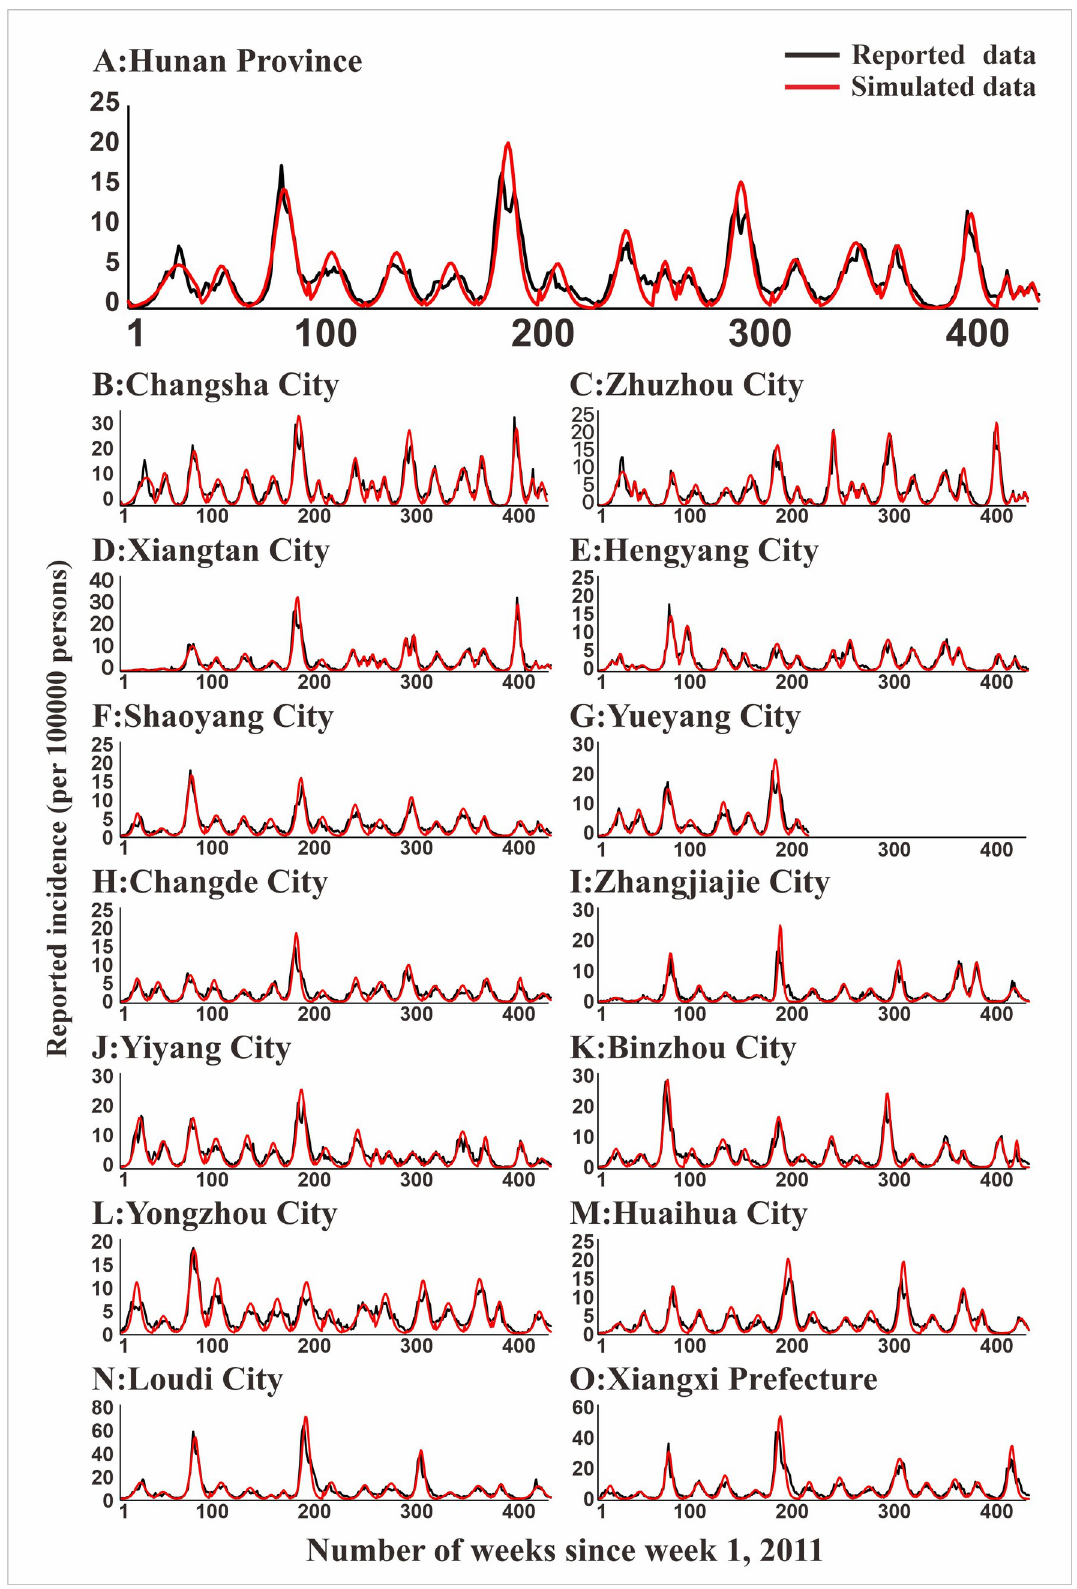
Fig 5. Epidemics of HFMD and LDE model fittings within Hunan Province and its 14 regions. (A: Hunan Province; B: Changsha City; C: Zhuzhou City; D: Xiangtan City; E: Hengyang City; F: Shaoyang City; G: Yueyang City; H: Changde City; I: Zhangjiajie City; J: Yiyang City; K: Chenzhou City; L: Yongzhou City; M: Huaihua City; N: Loudi City; O: Xiangxi Prefecture). https://doi.org/10.1371/journal.pntd.0009233.g005 PLOS NeglectedTropical Diseases | https://doi.org/10.1371/journal.pntd.0009233 March 24,